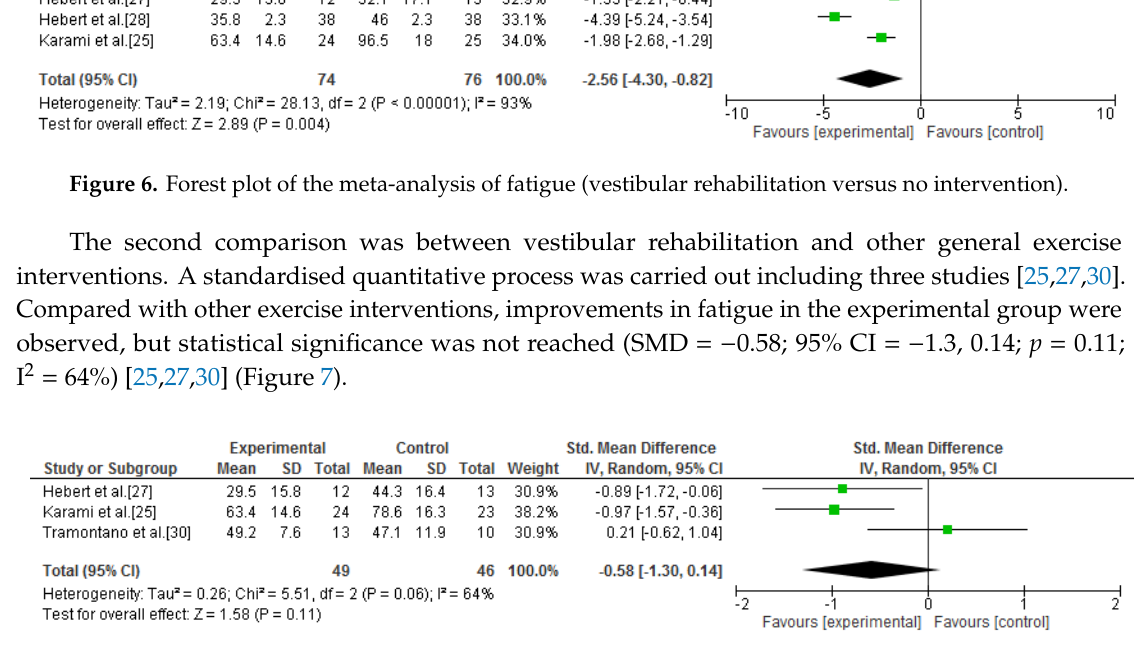
Figure 7. Forest plot of the meta-analysis of fatigue (vestibular rehabilitation versus other exercises).